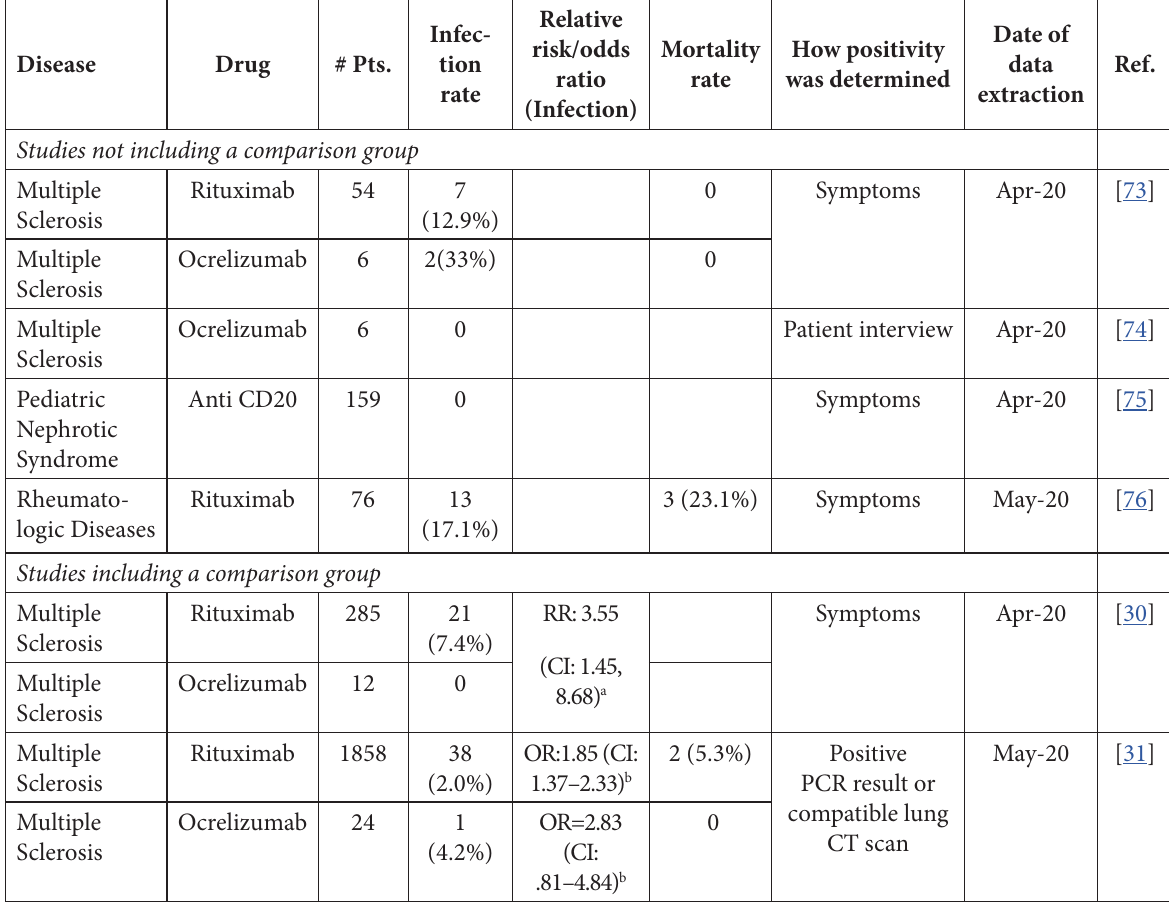
Table 2: Incidence of COVID-19 among patients receiving CD20 depleting drugs Disease Drug # Pts.